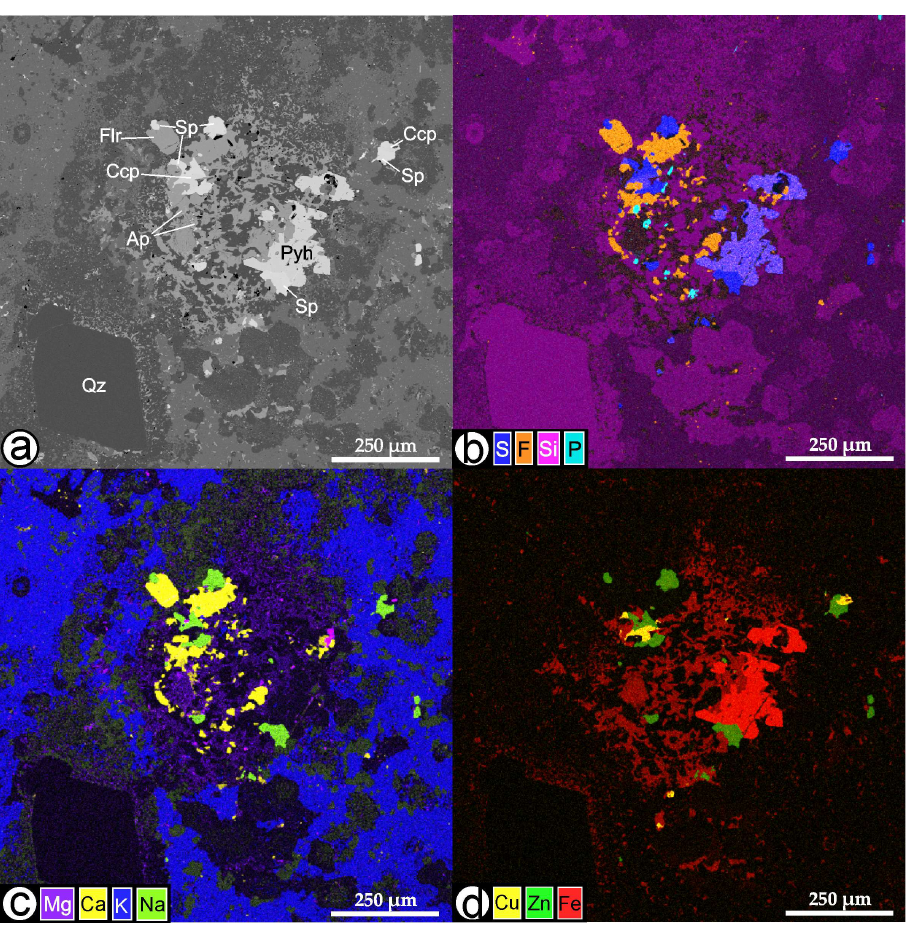
Figure 7. Element map of “nodule”–mineral separation in the ground mass. ( a )—BSE. Characteris- tic X-ray map displaying the distribution: S, F, Si, P—( b ); Mg, Ca, K, Na—( c ); and Cu, Zn, Fe—( d ). Abbreviations: Qz, quartz; Flr, fluorite; Ap, apatite; Sp, sphalerite; Ccp, chalcopyrite; and Pyh, pyrhotite.